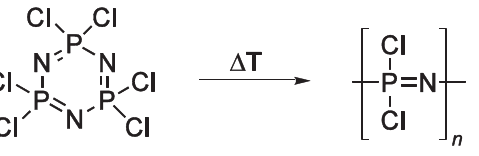
Figure 64. The ROP of hexachloro cyclo-triphosphazene at higher